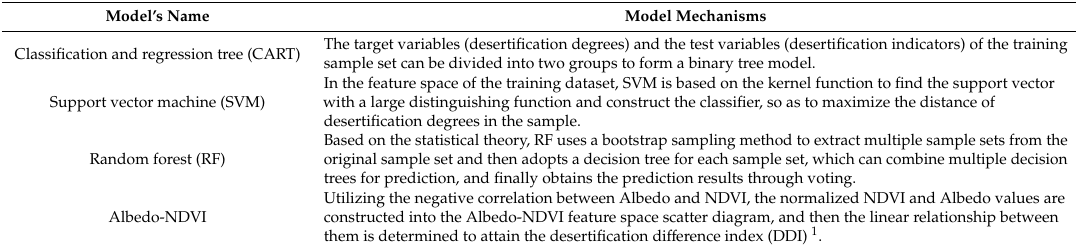
Table 4. Comparison of models’